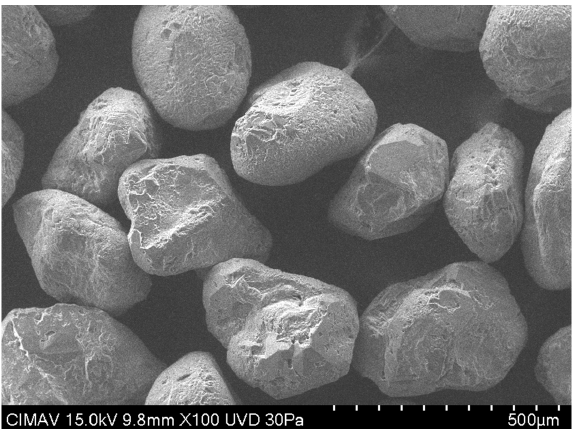
Figure 1. Ottawa silica sand used as abrasive particles in the abrasion resistance test.